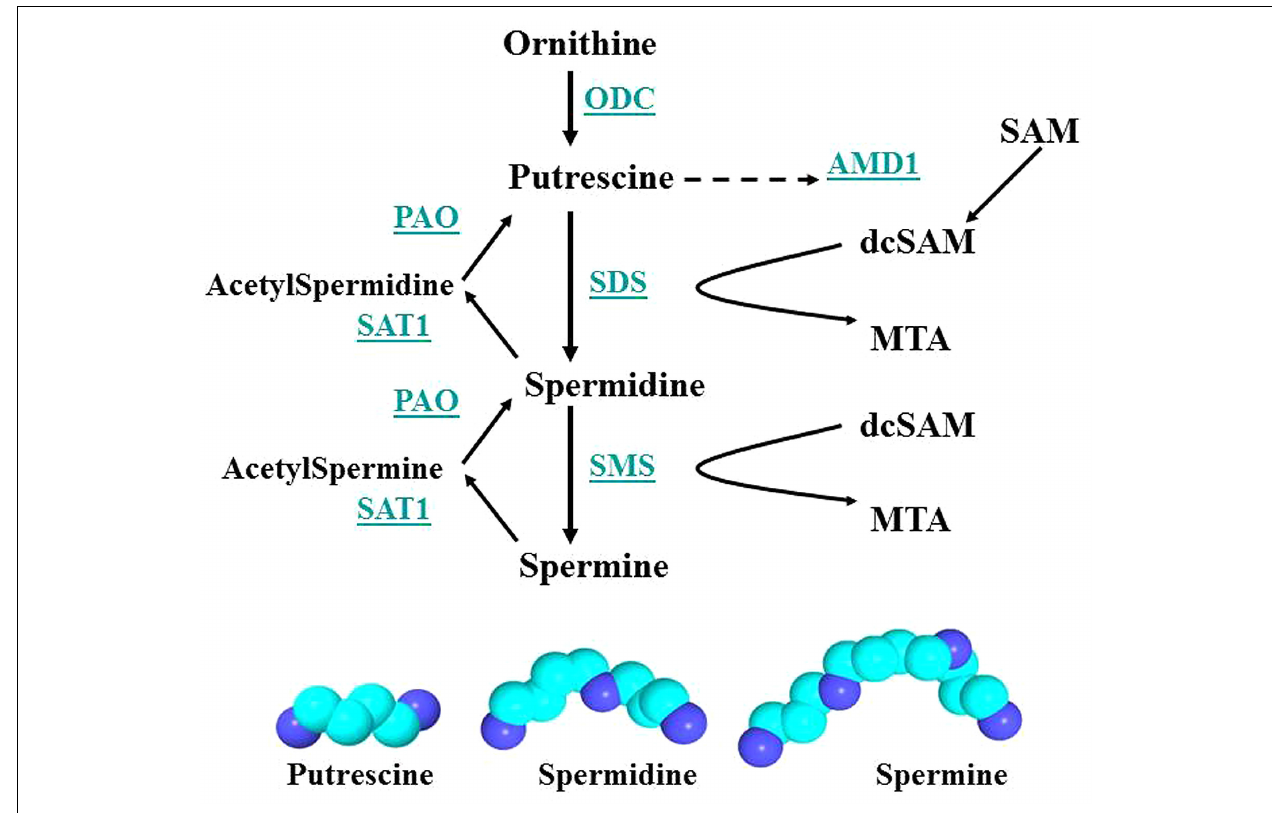
polyamines to putrescine, which then activates AMD1 and polyamine synthesis. Key: ODC, ornithine decarboxylase; SAM, S -adenosylmethionine; PAO, polyamine oxidase; AMD1, SAM decarboxylase; SAT1, spermidine/spermine- N 1-acetyltransferase; dcSAM, decarboxylated SAM; SDS, spermidine synthase; MTA, methyl thioadenosine; SMS, spermine